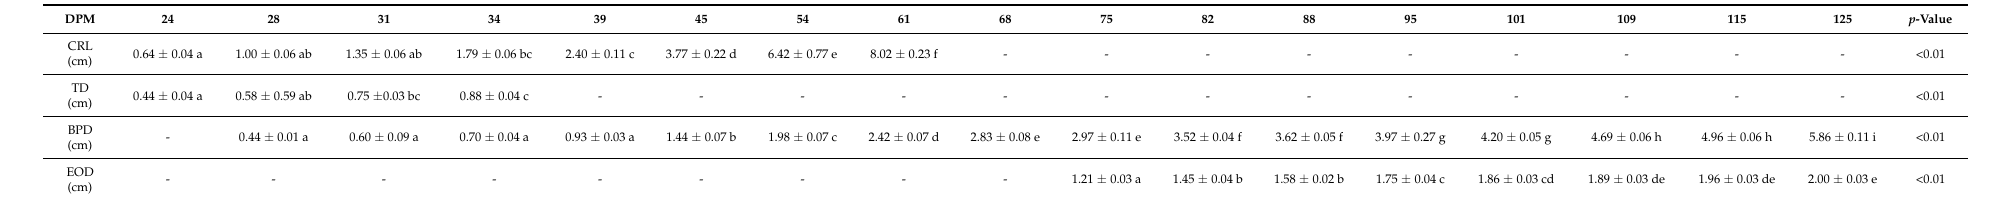
Table 1. Fetal growth indices measured on different days post-mating (dpm) throughout gestation in total goats under study ( n : 9). Mean ± Standard Deviation (SD). DPM: days post-mating, CRL: Crown-Rump Length, TD: Trunk Diameter, BPD: Biparietal Diameter, EOD: Eye Orbit Diameter. a–i: Different letters in the same row indicate significant differences.